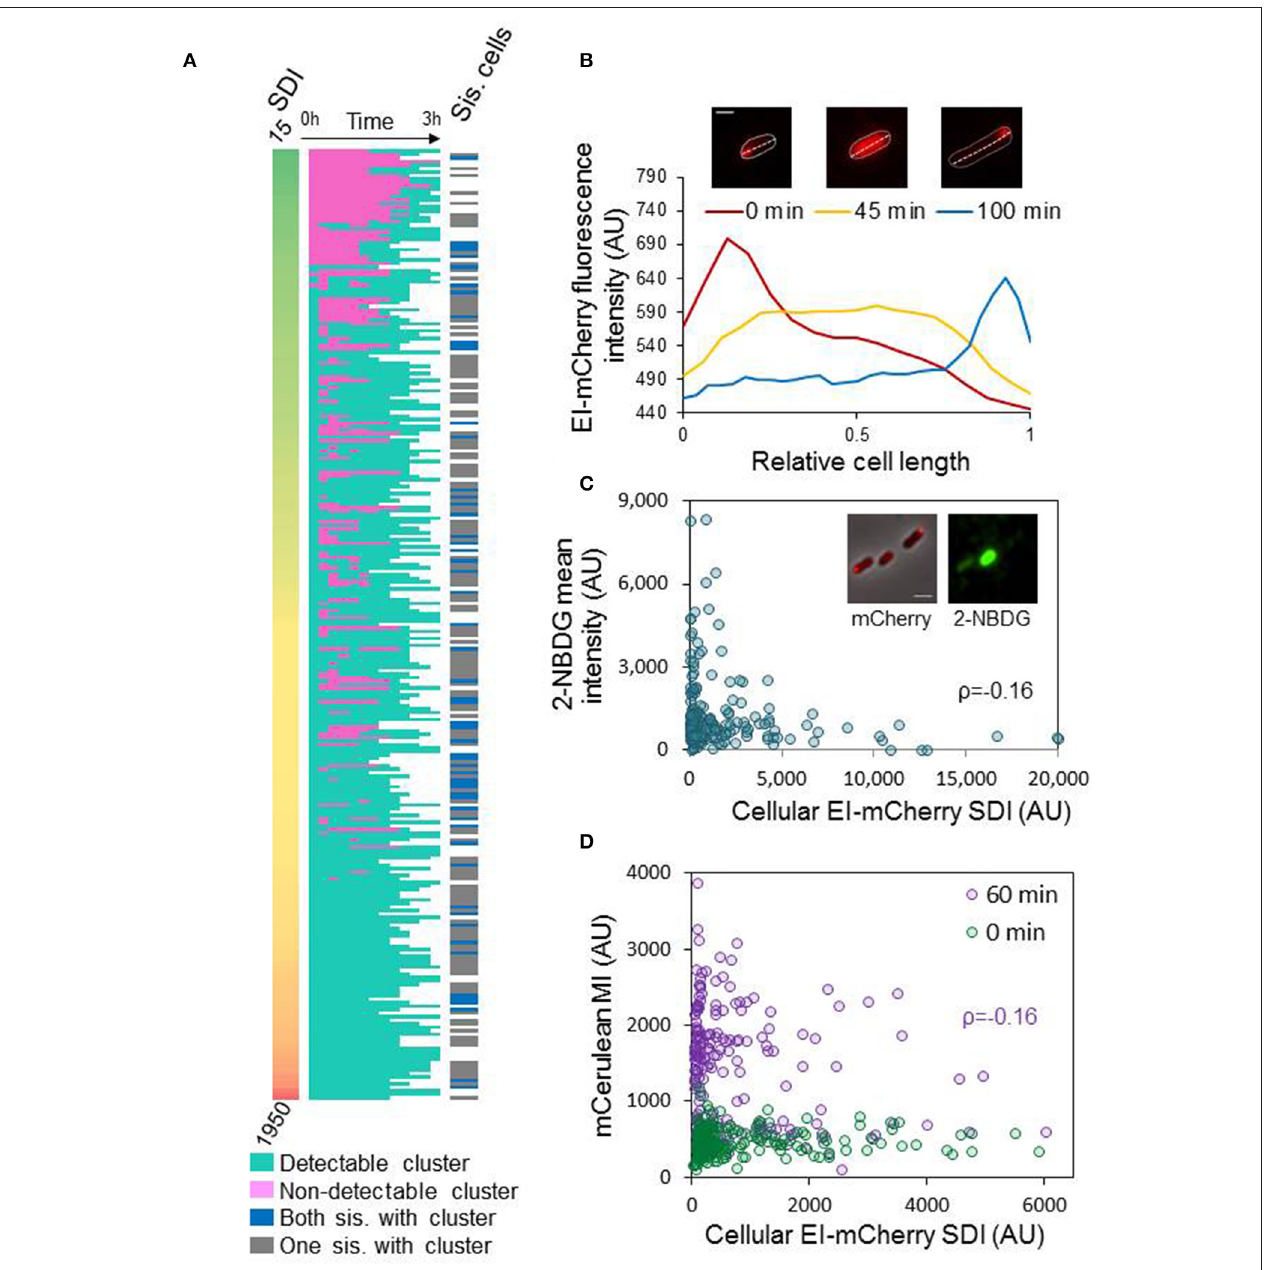
FIGURE 5 | Assembly of EI into clusters affects EI function and dynamics (A) Diluted ON cultures were spotted on an agar pad with fresh medium and the cells were observed at time 0, and every 15min till they divided or for 3h, by time-lapse microscopy. Left panels: heat map of standard deviation intensity (SDI) of EI-mCherry at time 0. Middle panels: heat map of cells with (turquoise) or without (pink) detectable EI-mCherry clusters over time, from time 0 till cell division (white, time after cell division). Right panels: Heat map of dividing cells with a cluster in each sister cell (blue) or only in one of the sister cells (gray) after 3h; white rows denote cells that did not divide within the 3h. (B) The images show a representative cell from the ON population, which has an EI-mCherry cluster at time 0 that completely disperses during growth (see image after 45min) and later reforms (see image after 100min). The contour of the cell is outlined. Scale bar corresponds to 1 µ m. The plot shows the EI-mCherry intensity in this cell vs. the relative cell length at the different time points at which the images were taken (0, 45, and 100min). (C) The images show a representative cells from the ON population, which express EI-mCherry, that were incubated with the glucose analog 2-NBDG. The mCherry fusion protein (red) and the 2-NBDG (green) were observed by fluorescence microscopy and are shown over the phase contrast images (gray) that were observed with phase microscopy. Scale bar 2 µ m. The scatter plot presents the 2-NBDG mean intensity (AU) vs. the EI-mCherry SDI (AU) ( n = 194). Pearson correlation ρ = 0.16; p -value = 0.02. (D) The scatter plot shows the mean intensity (MI) of mCerulean expressed from Pnag, vs. the cellular EI-mCherry SDI (AU) at the moment of transition to NAG-continuing medium (0min; green cycles; n = 222) and after an hour (60min; purple cycles; n = 274). Pearson correlation for the “60 min” plot ρ = − 0.16; p -value = 0.007. Pearson correlation for the “0 min” plot ρ = 0.06; p -value = 0.366.